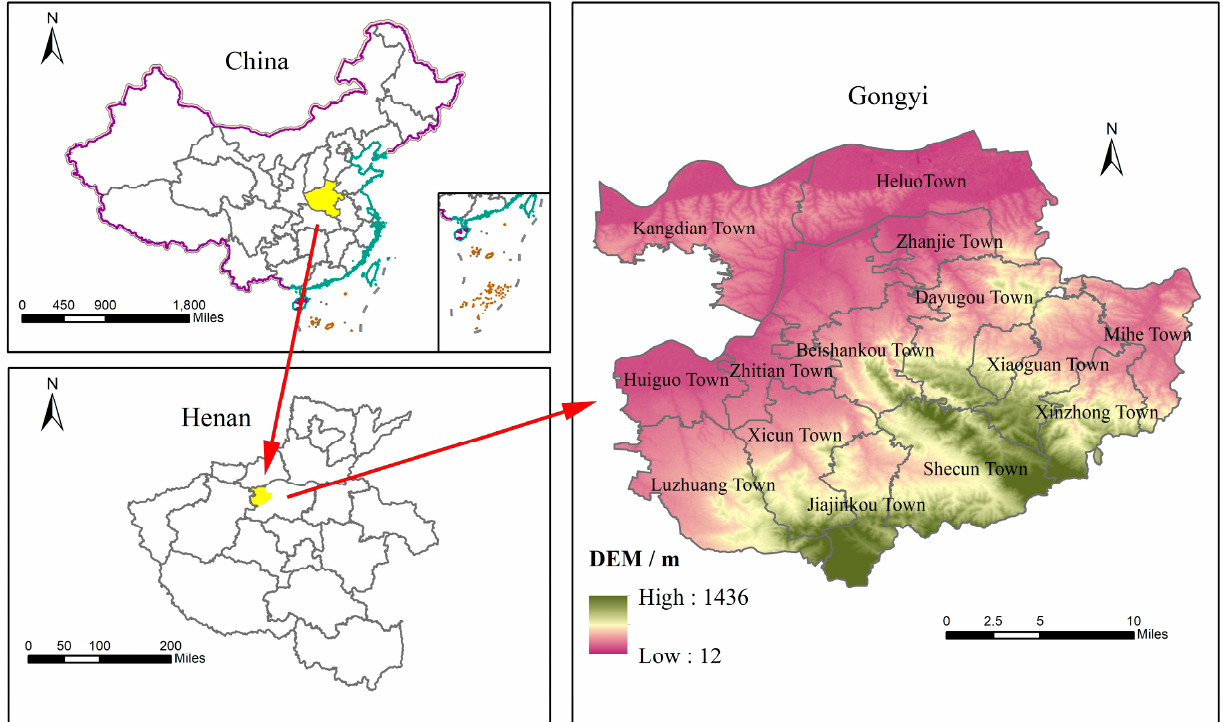
Figure 1. Map of the locations of 14 townships in Gongyi City.